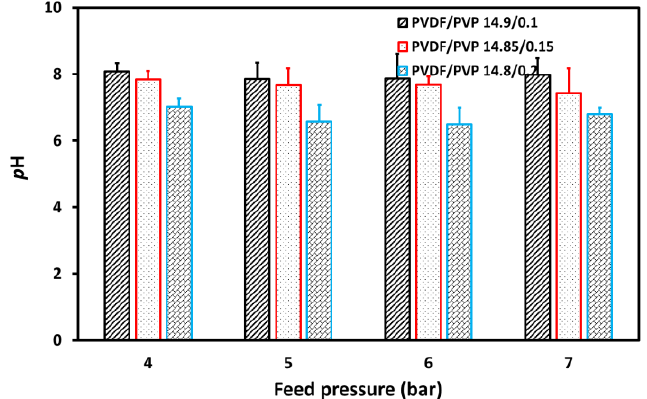
Figure 10. The pH of permeated water at various feed pressures in the UF process for tofu wastewater.